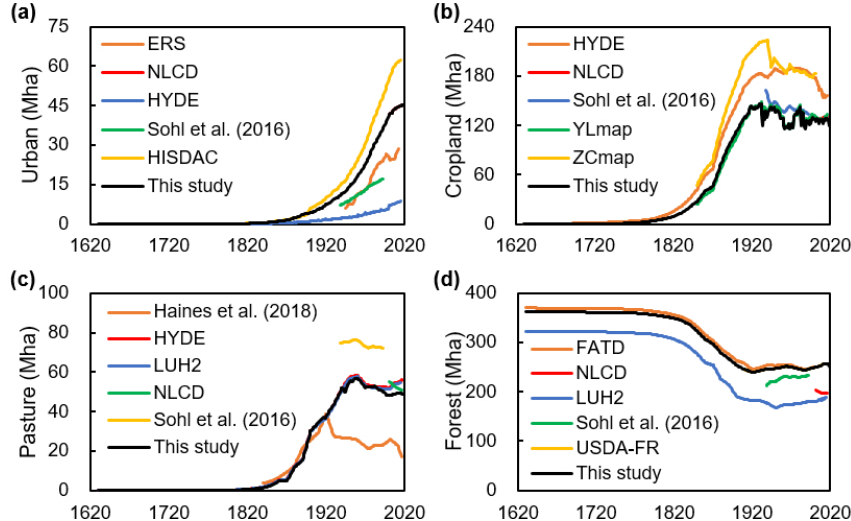
Figure 12. Comparison with other datasets for the conterminous United States: urban land (a) , cropland (b) , pasture (c) , and forest (d) . NLCD: National Land Cover Database, HYDE: History Database of the Global Environment, HISDAC: Historical Settlement Data Com- pilation, ERS: Economic Research Service, YLmap: Yu and Lu (2017) cropland density, ZCmap: Zumkehr and Campbell (2013) historical fractional cropland areas, LUH2: Land Use Harmonization, FATD: Forest Area Trend Data, and USDA-FR: USDA Forest Resources of the United States of